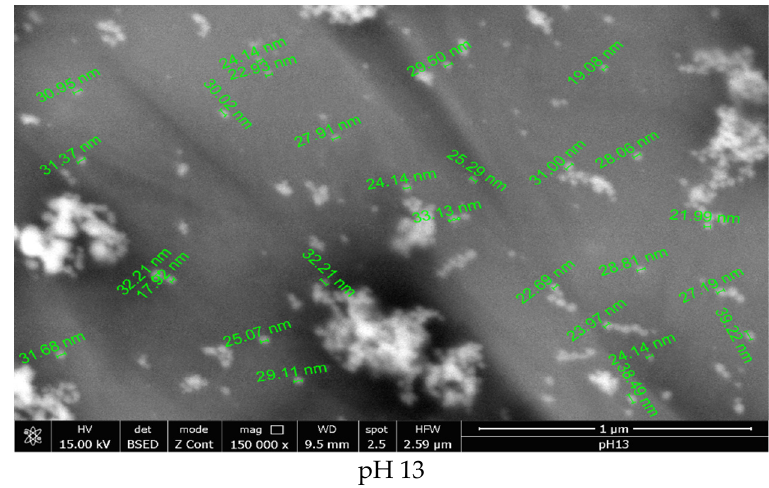
Figure 3. Scanning electron micrographs recorded for samples prepared at pH values between 8 and 13.